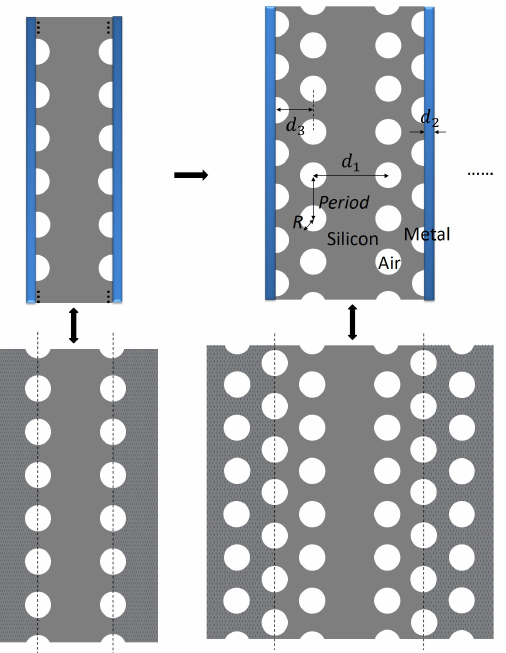
Figure 1. The schematic of different waveguide structures and their equivalent mirror structures with numbers of air-hole columns of 0.5,1.5, respectively, at each side of the waveguide cores. Basic parameters of the waveguides are: d 1 = 0.745 µ m, d 2 = 0.1 µ m, d 3 = R = 0.13 µ m, (cid:101) a = 1 and (cid:101) s = 12.04. The metal is silver.